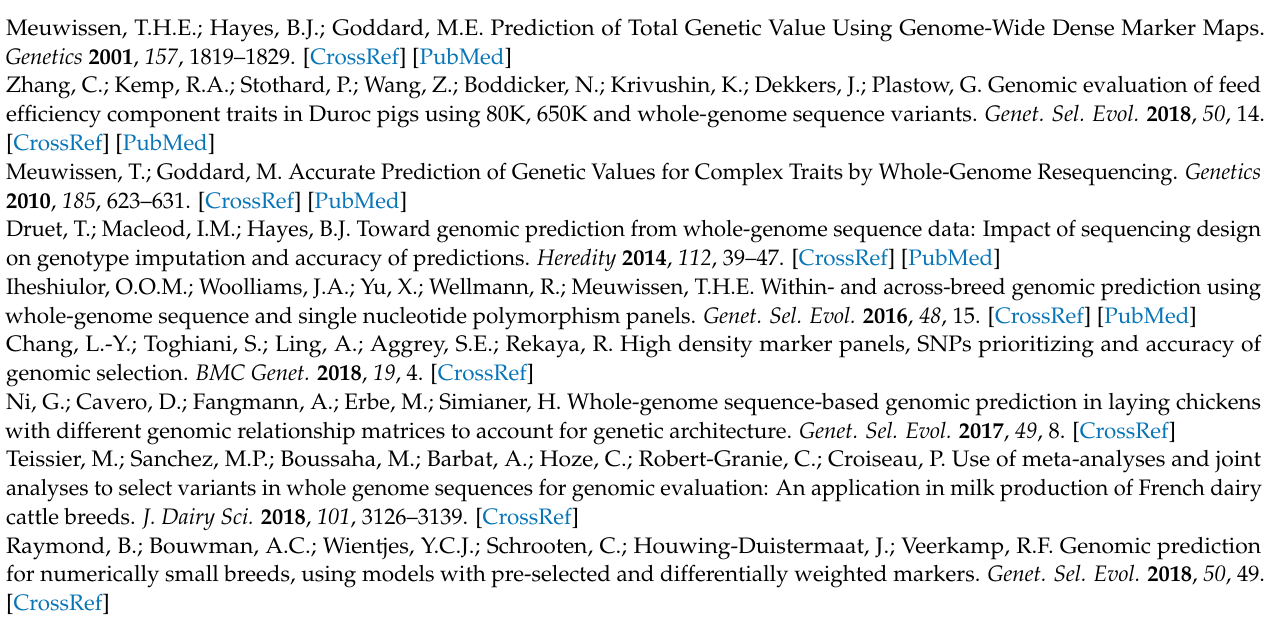
Table S4: Significant SNPs identified in meta-analysis for four traits. Table S5: Sequencing depth of WGS data of reference panel. Table S6: Genomic prediction accuracies of different strategies by traits. Figure S1: Manhattan plots for BTHWT (birth weight) by breed in different GWAS approaches. Figure S2: Manhattan plots for BW (body weight) by breed in different GWAS approaches. Figure S3: Q-Q plots for CL_GWAS of four growth traits in Yorkshire and Landrace population. Figure S4: Q-Q plots for IL_GWAS of four growth traits in Yorkshire and Landrace